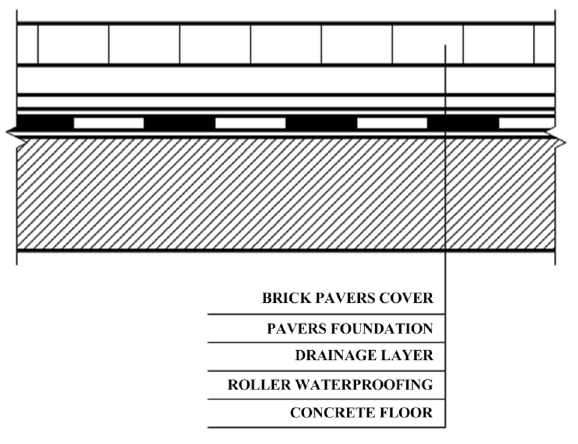
Fig. 14. Section of car park roofing